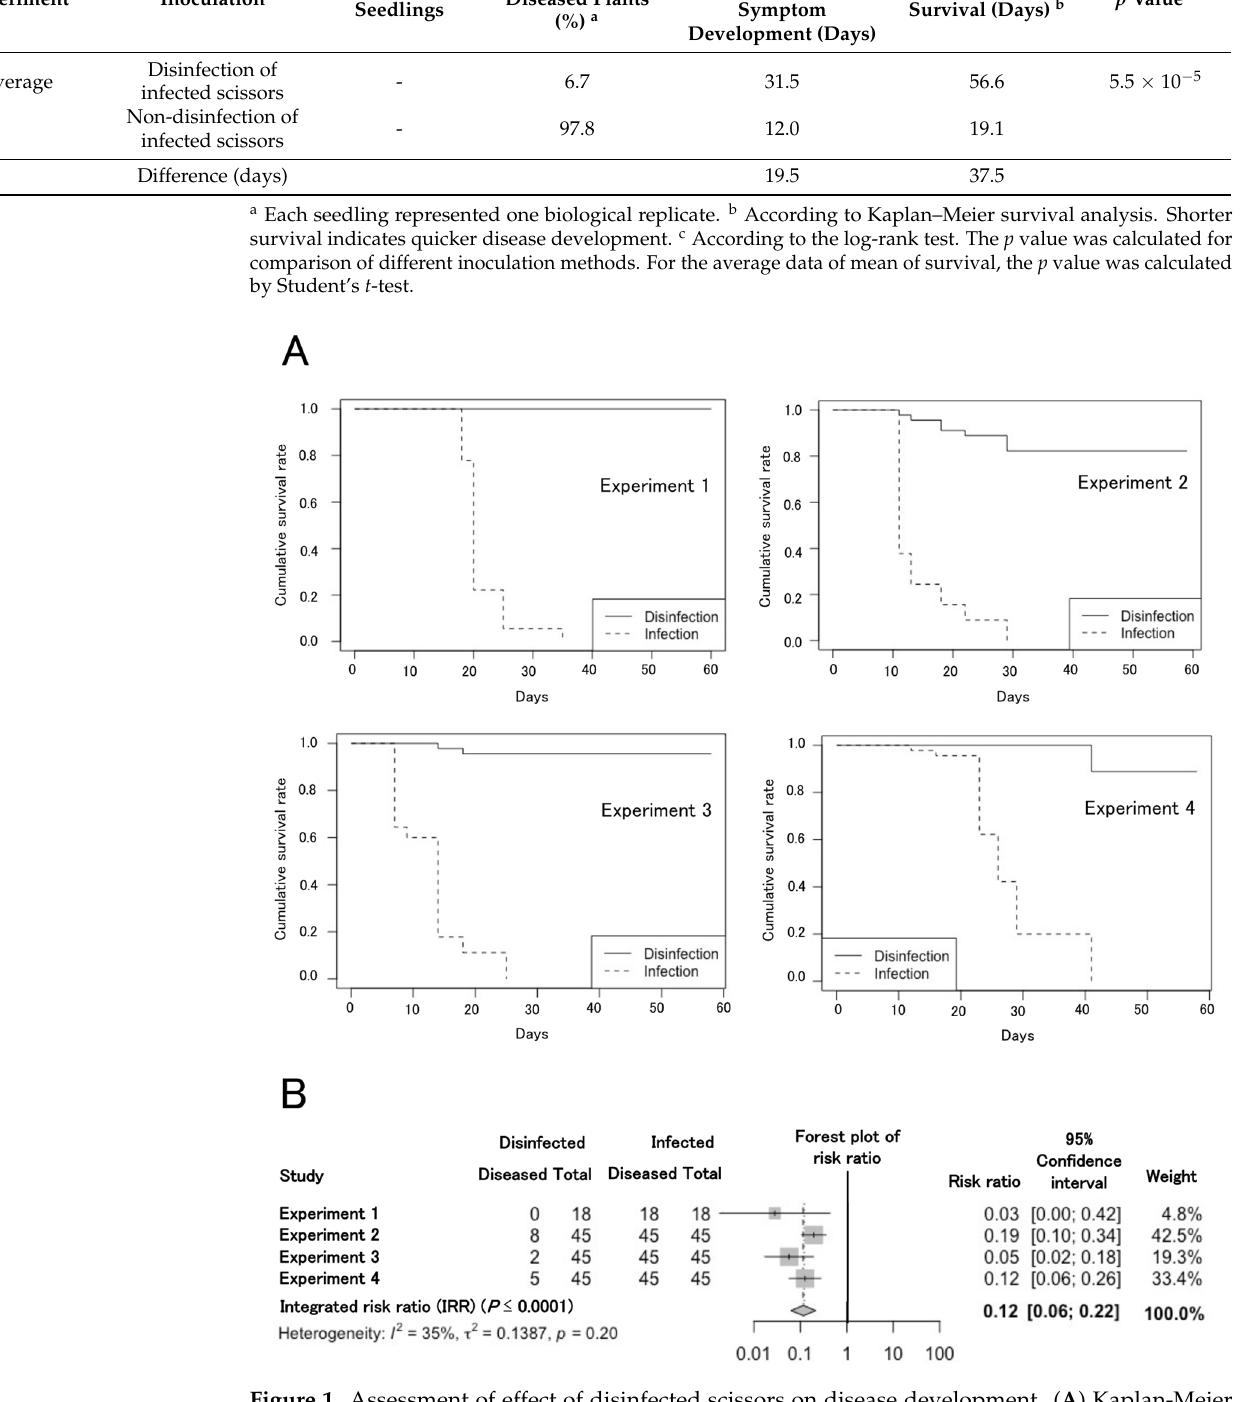
Figure 1. Assessment of effect of disinfected scissors on disease development. ( A ) Kaplan-Meier analysis of plant survival after infection by cutting with disinfected or infected scissors. ( B ) Integrated evaluations based on meta-analyses of effects of cutting with disinfected scissors. The center of each lozenge marks the value of the integrated risk ratio. Each gray square marks the value of the risk ratio (RR), and the size of the square indicates the weight of each experiment. The spread (horizontal line) indicates the 95% confidence interval. Table 1. Effects of ethanol disinfection on disease development and plant survival.